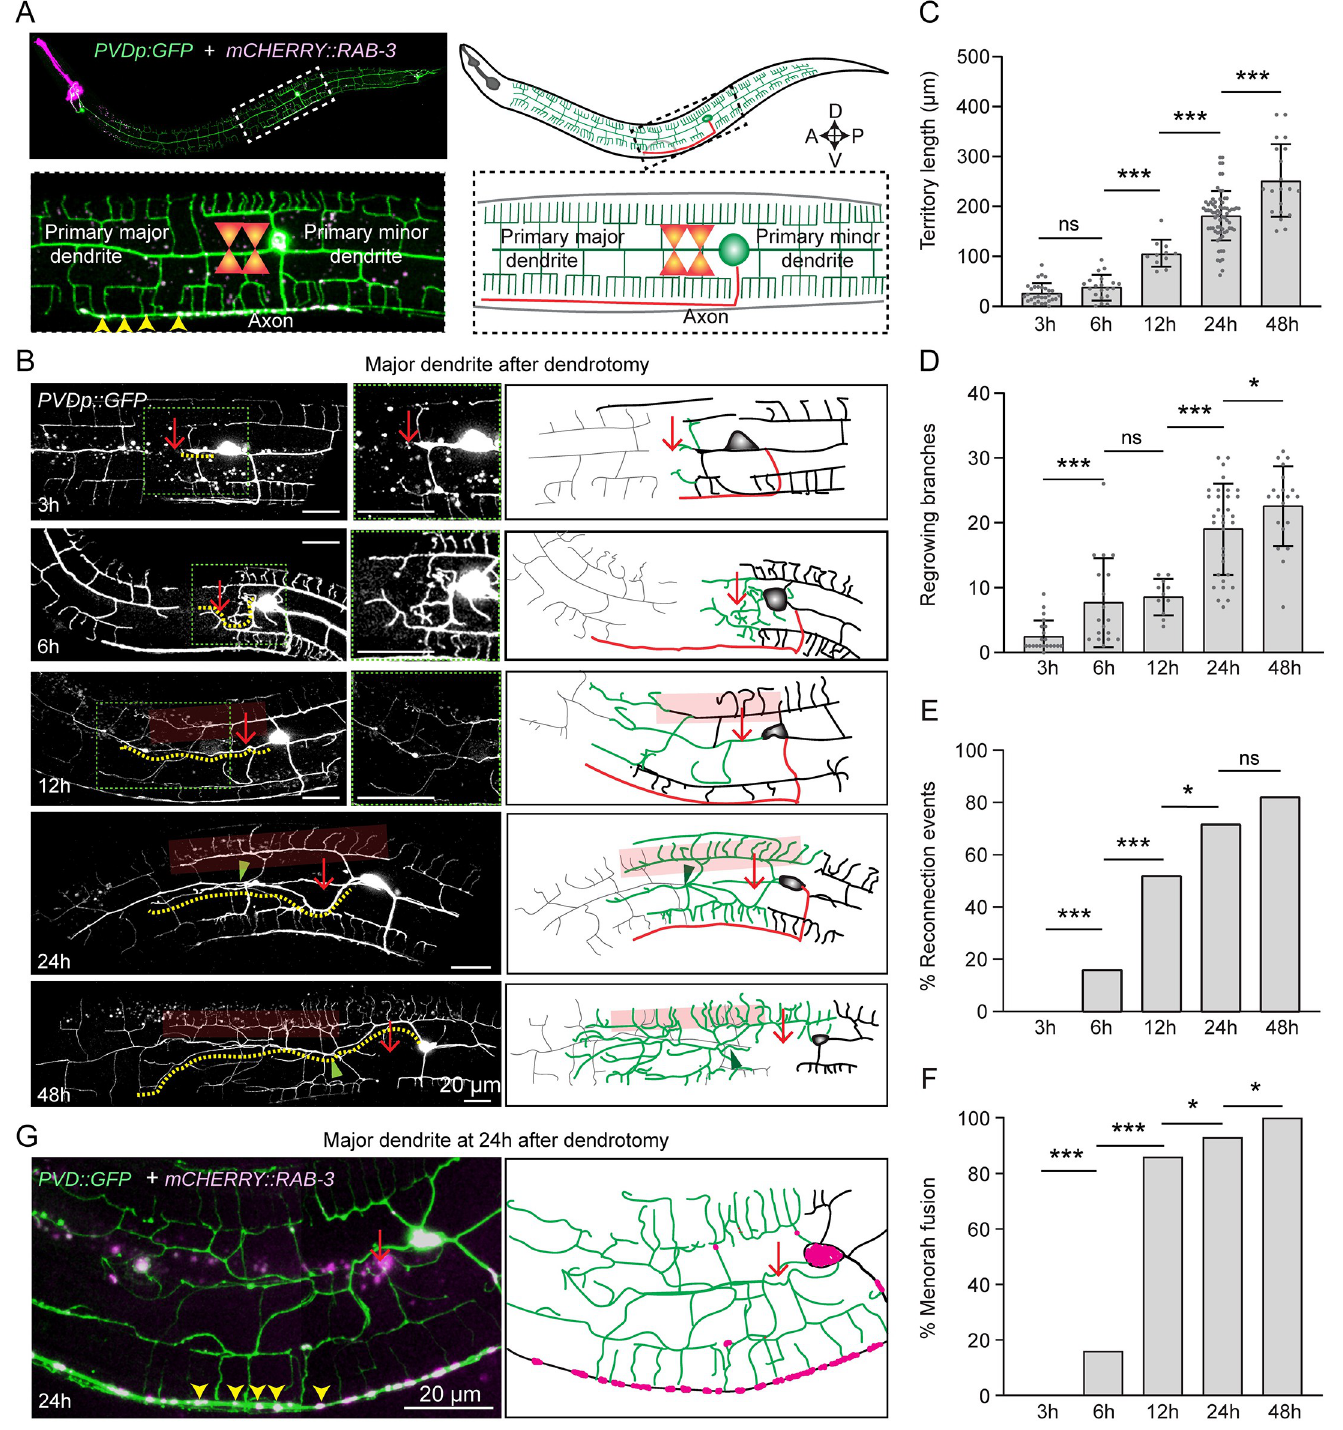
Fig 1. Primary dendrites of PVD neurons show multiple regenerative responses following dendrotomy. (A) Representative confocal image and illustration of dendrotomy paradigm in PVD neuron labeled with soluble GFP wdIs52 ( pF49H12 . 4 :: GFP )and axon marked with mCherry::RAB-3 ( kyIs445 , pdes-2 :: mcherry :: RAB-3 ) with the region of interest (white dashed rectangle) magnified below. The primary dendrites and the axon are highlighted. The yellow arrowheads mark the axonal RAB-3 punctae. The dendrites and axons are illustrated in green and red color respectively. The two-shot dendrotomy cuts using a femtosecond laser is also illustrated. (B) The confocal images and schematics (right) showing the PVD neurons in the wild-type background at 3h, 6h,12h, 24h and 48h post-dendrotomy using two laser shots. At 3h after injury, the gap caused due to the two laser shots is shown with a red arrow. A magnified view of the regrowing end within the green dotted